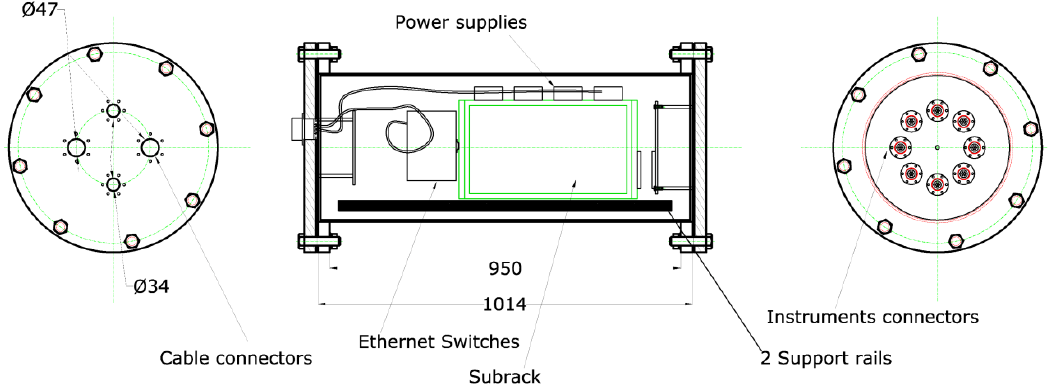
Figure 3. The architecture of the main cylinder (indicated by B in Figure 2) holding the junction box and the sensors within the OBSEA seafloor cabled observatory. Element sizes and distances are reported in